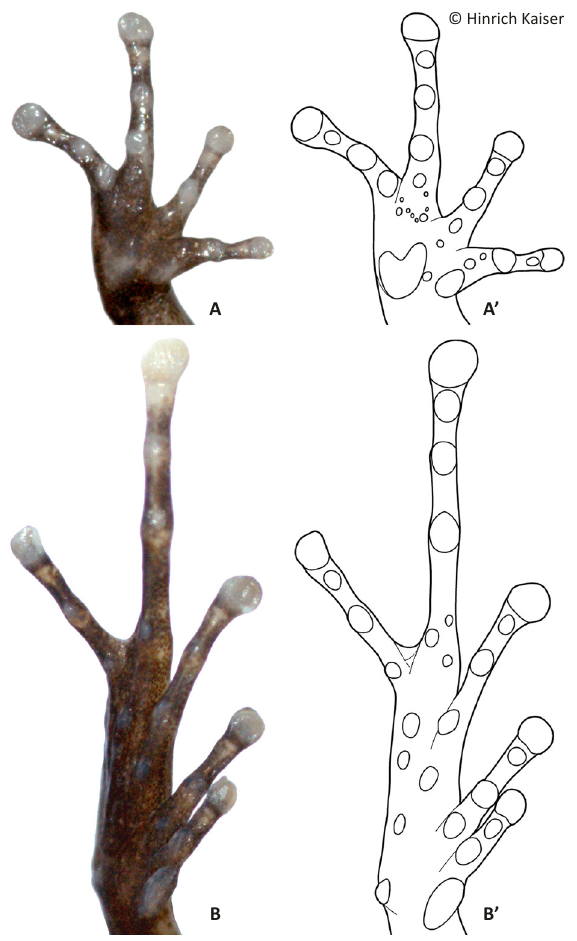
Image 14. Photographs and drawings of hand and foot of the paratopotype of Pristimantis geminus sp. nov. (CVULA 7443). (A, A’) Right hand. (B, B’)